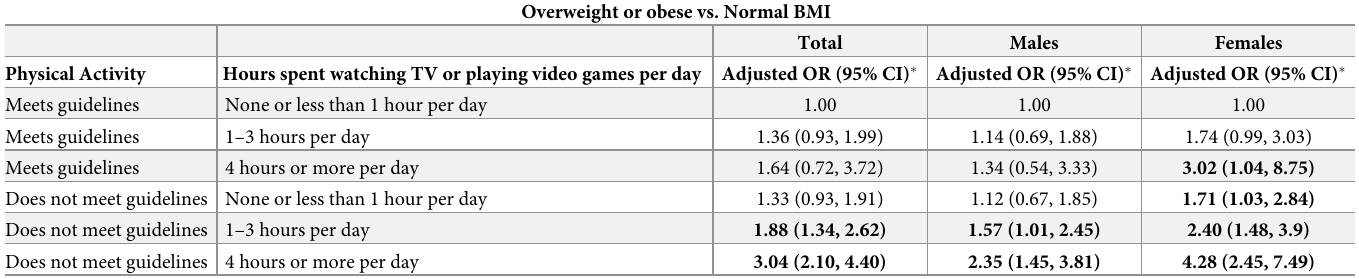
Table 4. Results of logistic regression analysis of the effect modification by physical activity on the association between time spent watching TV or playing video games and overweight.